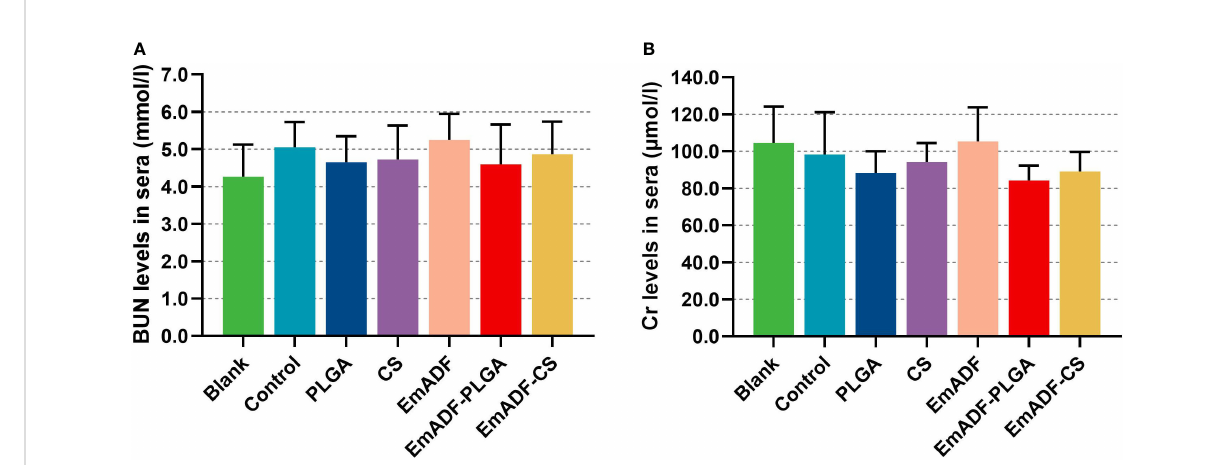
FIGURE 4 The toxicity of recombinant EmADF proteins and its nanospheres. Based on the urease-indophenol and sarcosine oxidase method, the levels of BUN (A) and Cr (B) were investigated by the commercially available kits. Each group involved fi ve biological replicates, and each replication was detected once. Values were estimated using one-way ANOVA analysis followed by Dunnett ’ s test. Comparisons among EmADF, EmADF-PLGA, and EmADF-CS group were conducted by ANOVA following Bonferroni ’ s correction. Values were presented as the mean of the mean ±